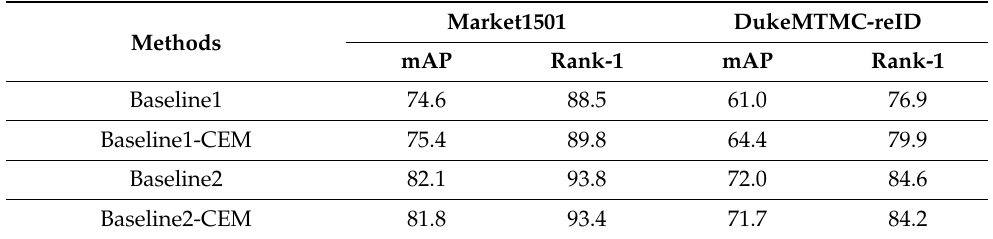
Table 1. The model performance (%) after adding the contour map as a feature supplement on two different baseline